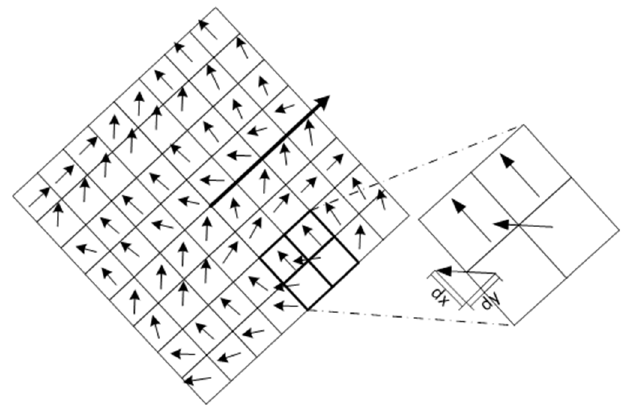
Figure 3. An example 4 × 4 pixel set showing how the SURF algorithm finds object features